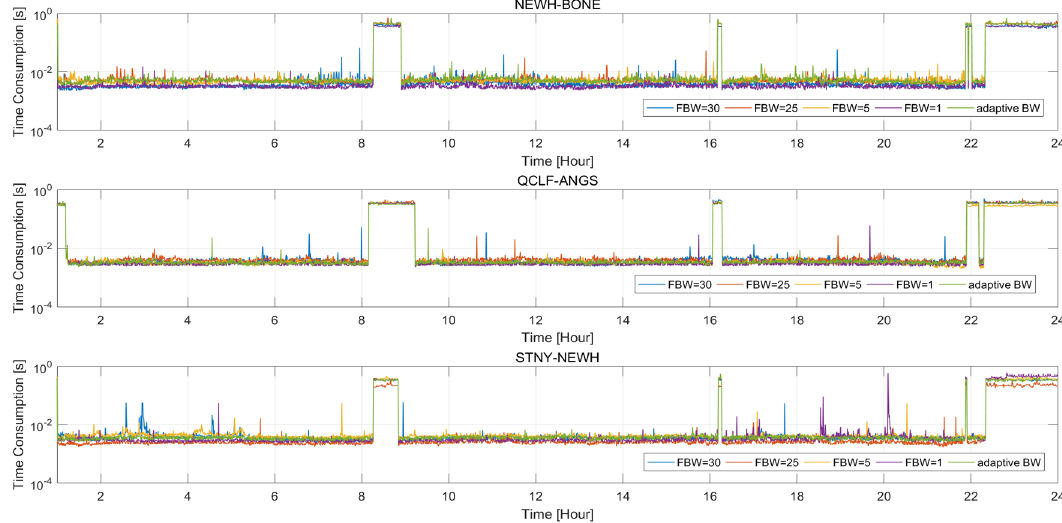
Figure 6. Time consumption with different KBW strategies on NEWH-BONE, QCLF-ANGS, STNY-NEWH.